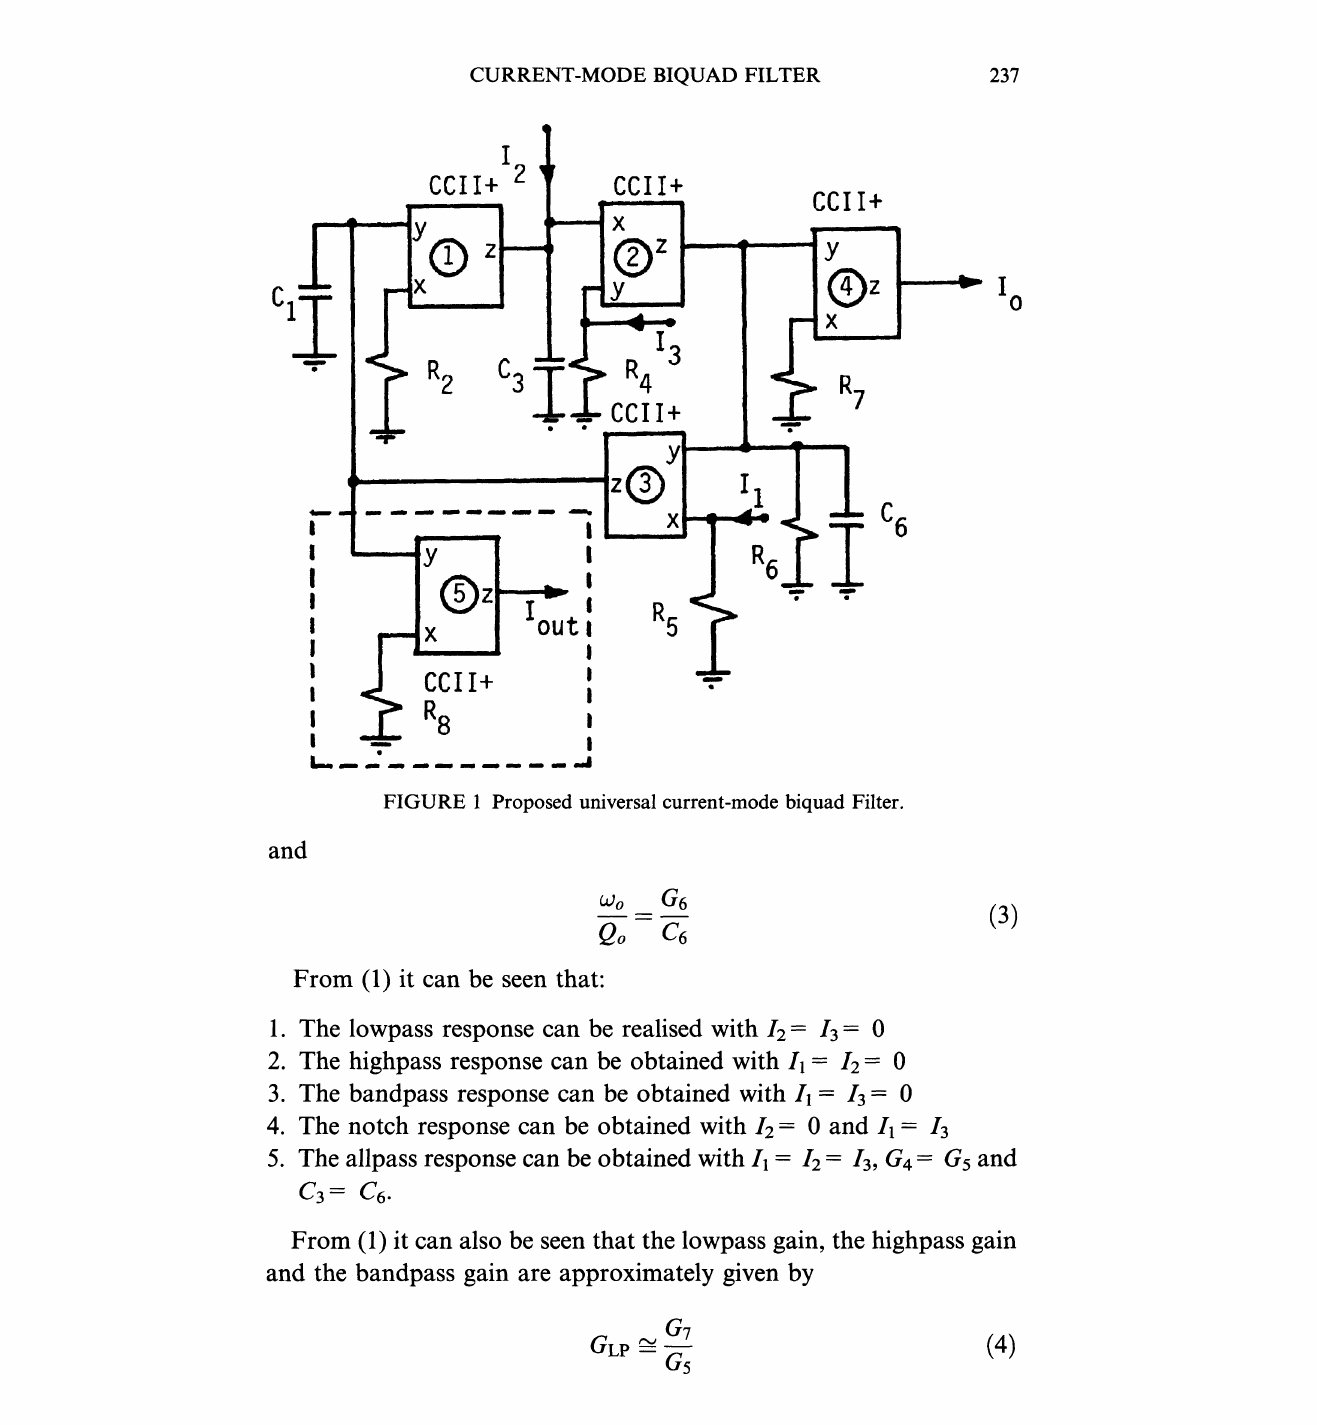
FIGURE Proposed universal current-mode biquad